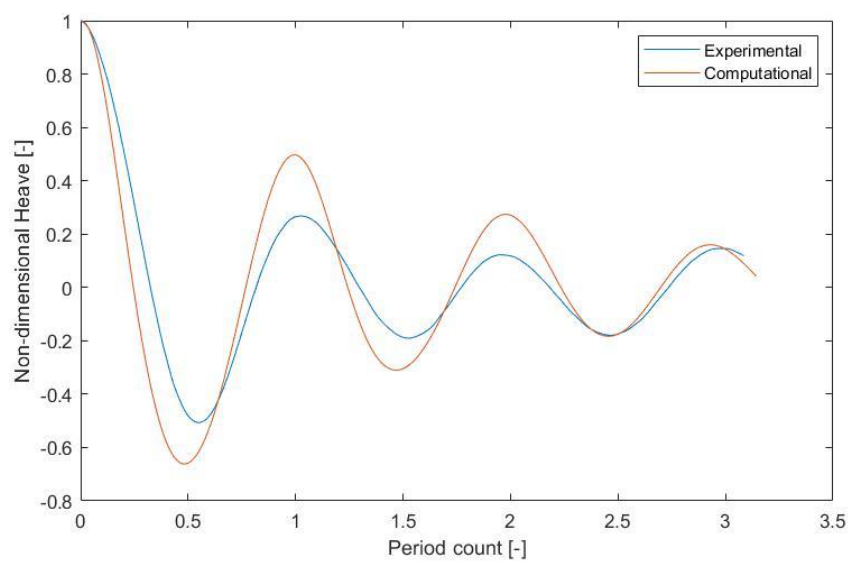
Figure 6. Signal comparison of the experimental (blue) and computational (orange) decays without the interaction of mooring systems.